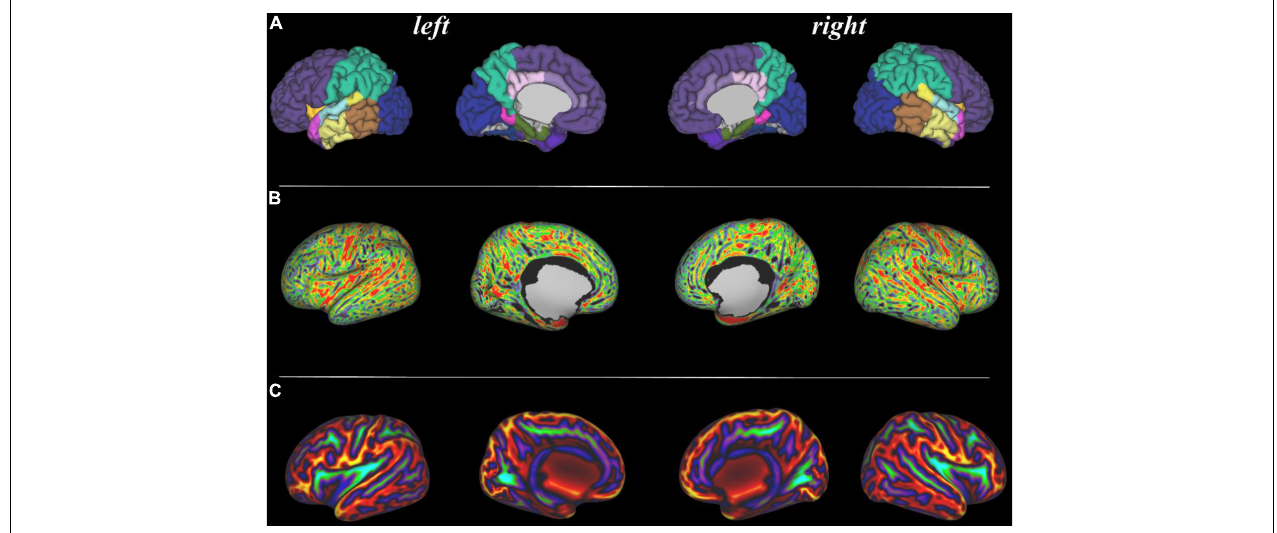
FIGURE 5 | Surface projections using the dHCP structural pipeline for the same infant. ( A: top row) 87 region neonatal brain atlas projected onto the pial surface; ( B: middle row) Cortical thickness projected onto the inflated cortical surface; and ( C: bottom row) Sulcal depth projected onto the inflated cortical surface.